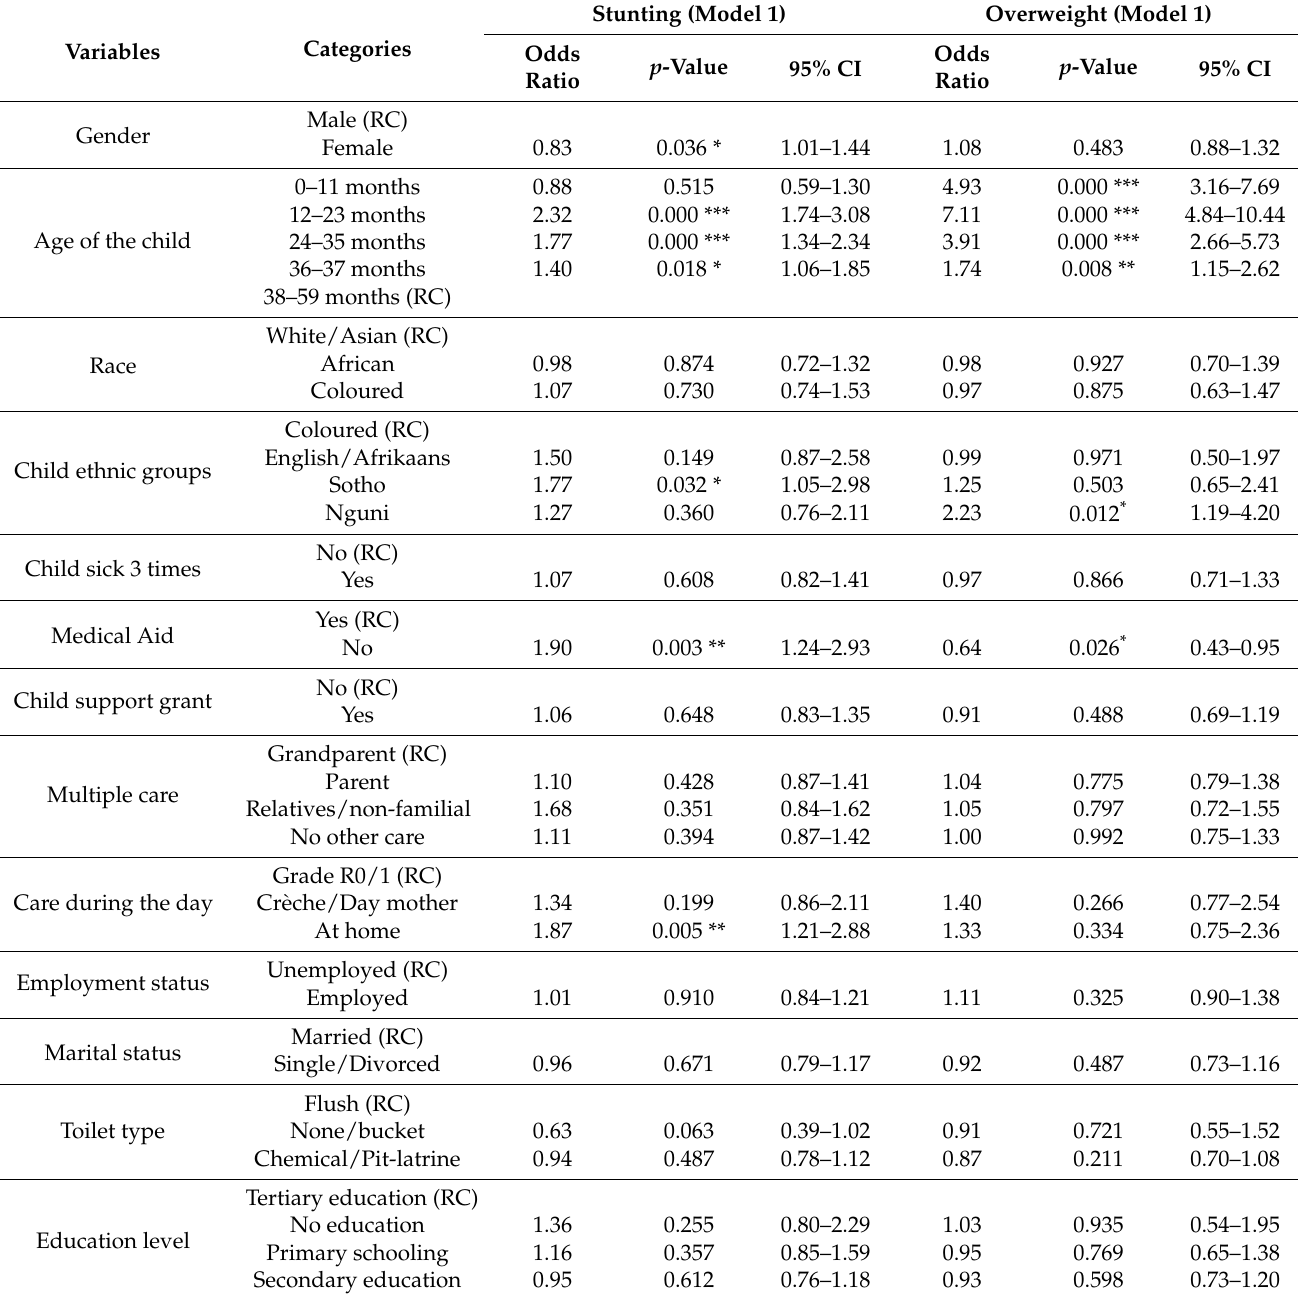
Table 4. Individual child and caregiver characteristics associated with child stunting and